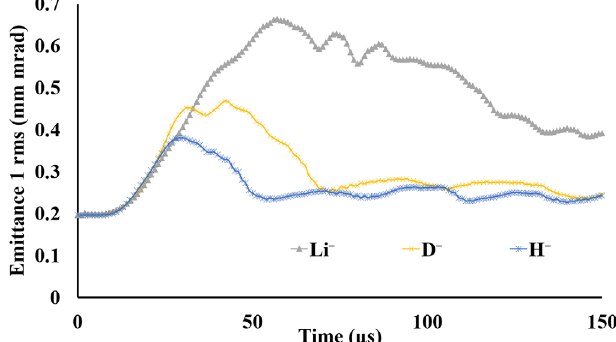
FIG. 6. Emittance time evolution for the 50 keV negative beams in the 0.5 m drift section using the secondary particles to carry the